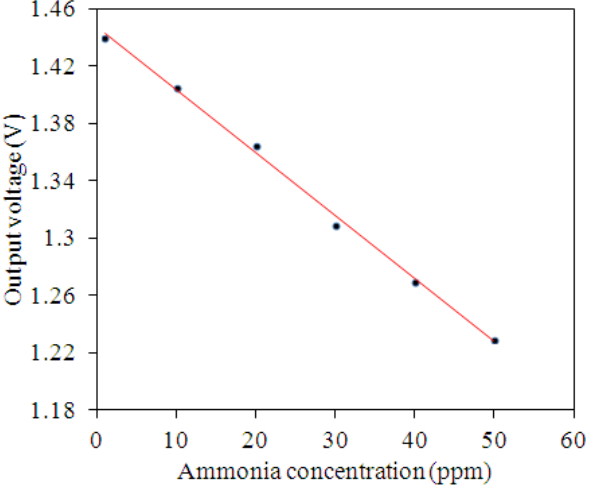
Figure 13. Measured results of the output voltage for the ammonia